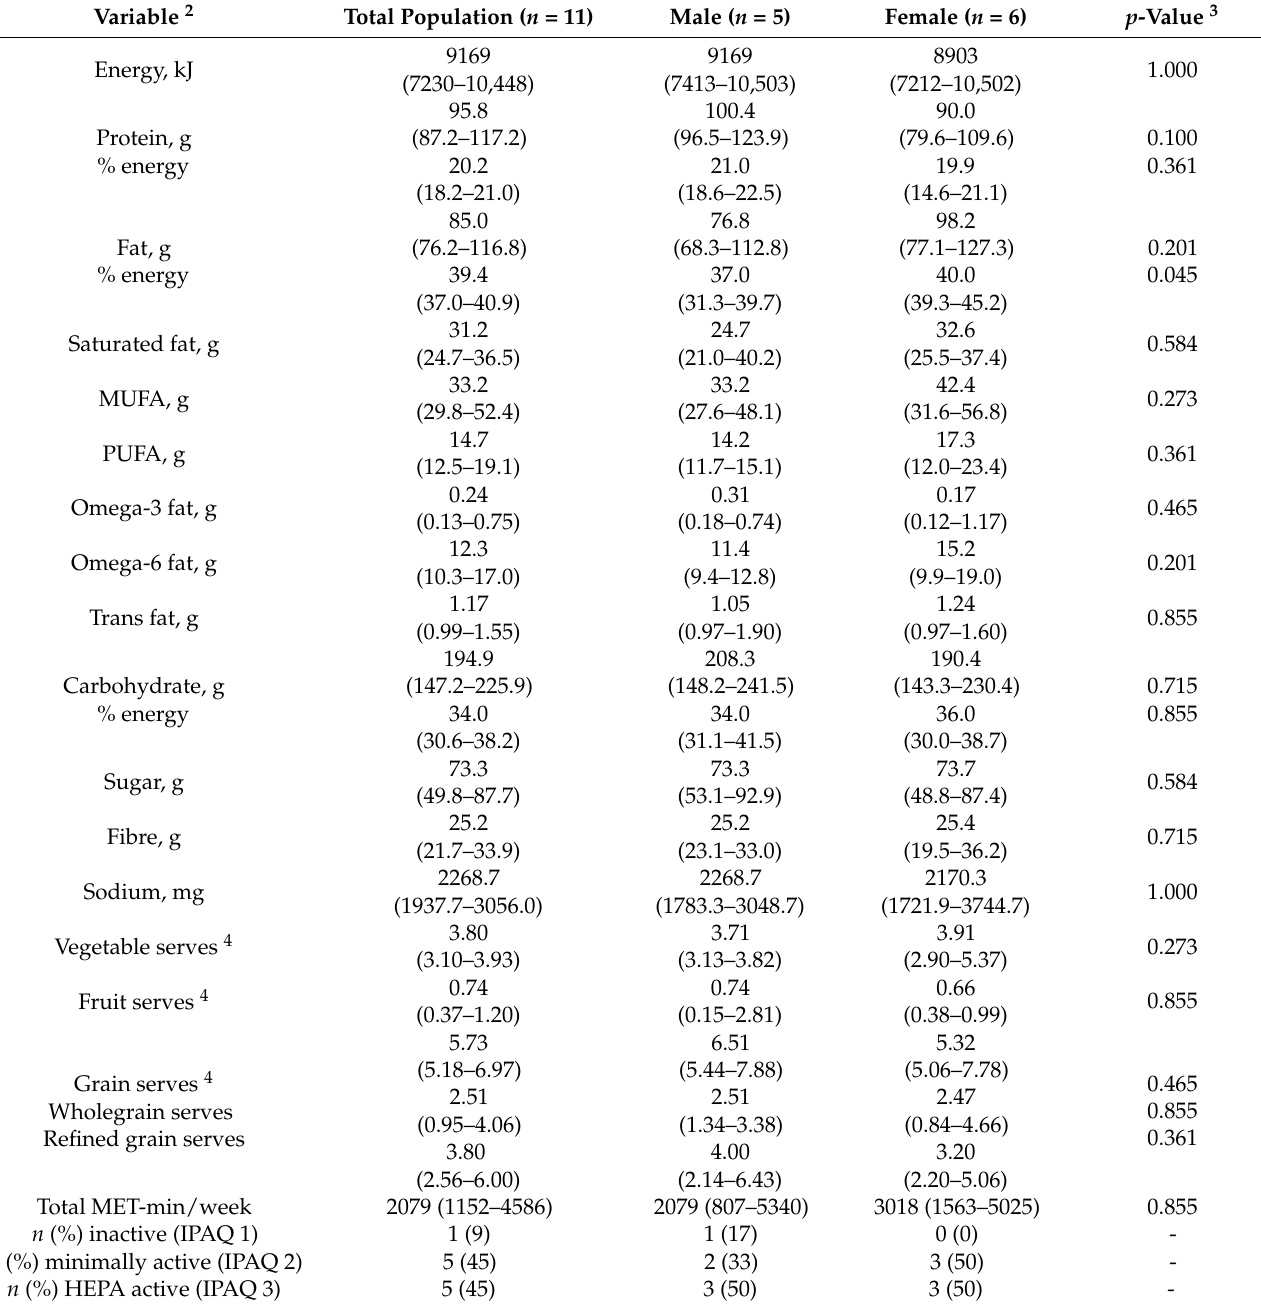
Table 3. Baseline dietary intake per day and physical activity levels of study participants 1 .